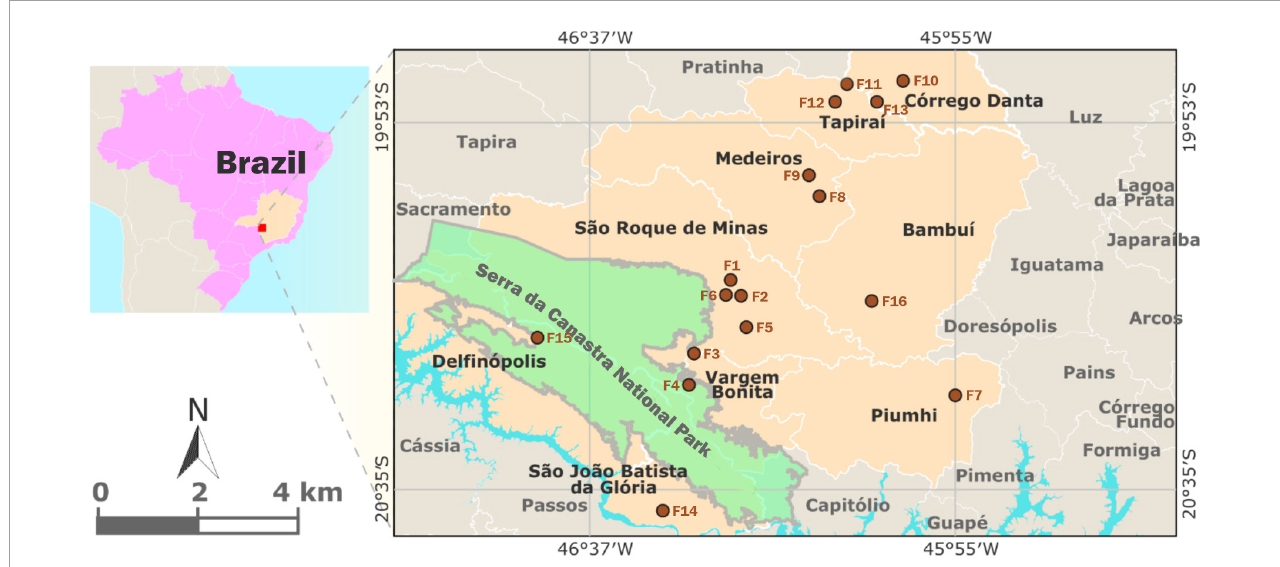
FIGURE1 Cities involved in the production of Canastra cheese, Minas Gerais State, Brazil (cities area in beige color). Brown spots indicate the farms where the cheese samples were collected.